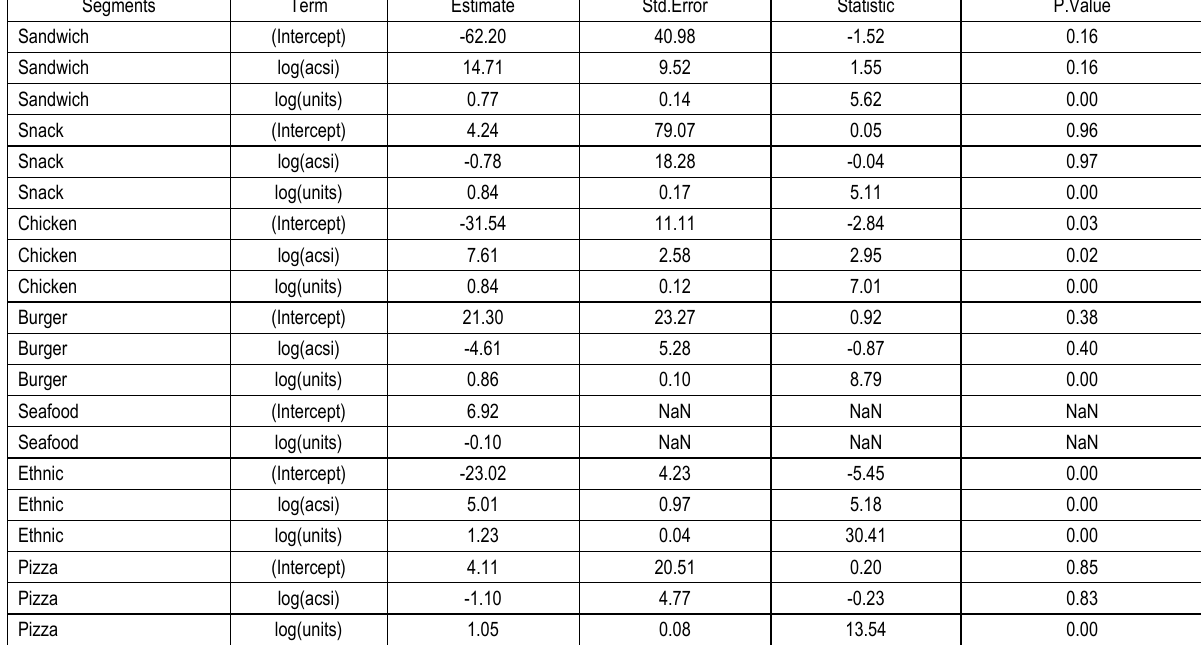
Table 17. Coefficients of regression